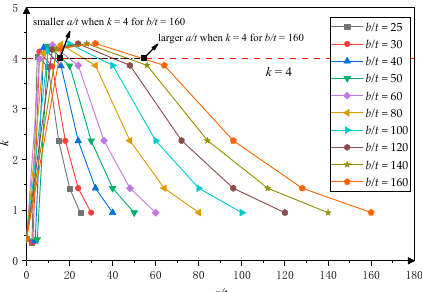
Figure 4. Values of k for different simple edge stiffener width − thickness ratios.